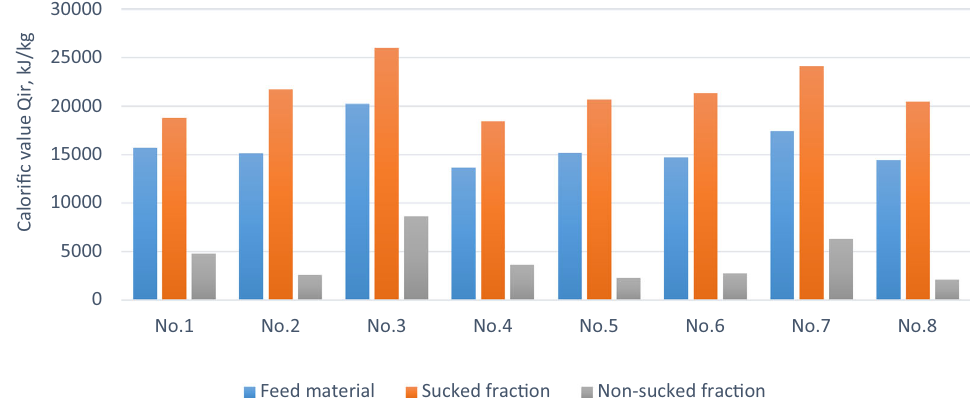
Fig. 15 Calorific value with respect to the origin of the feed material (grain-size class of 20–50 mm)